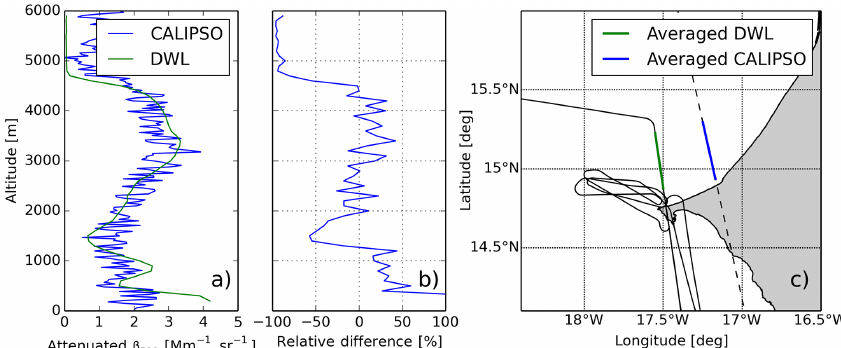
Figure 20. (a) Comparison of the averaged attenuated backscatter profiles retrieved from the DWL (green) and the corresponding averaged profile measured by CALIPSO (blue) during its overpass over Dakar region on 12 June. (b) Relative difference between the backscatter profiles retrieved from the DWL and the corresponding profile measured by CALIPSO as function of the altitude. (c) DLR Falcon (black, solid) and CALIPSO (black, dashed) tracks, together with the averaged sections (green for the DWL and blue for